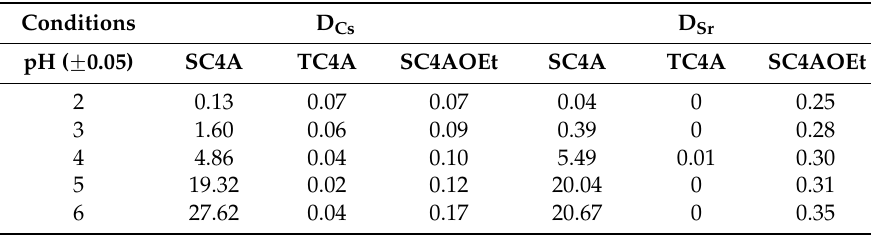
Table 3. Distribution ratio of metals with a change in